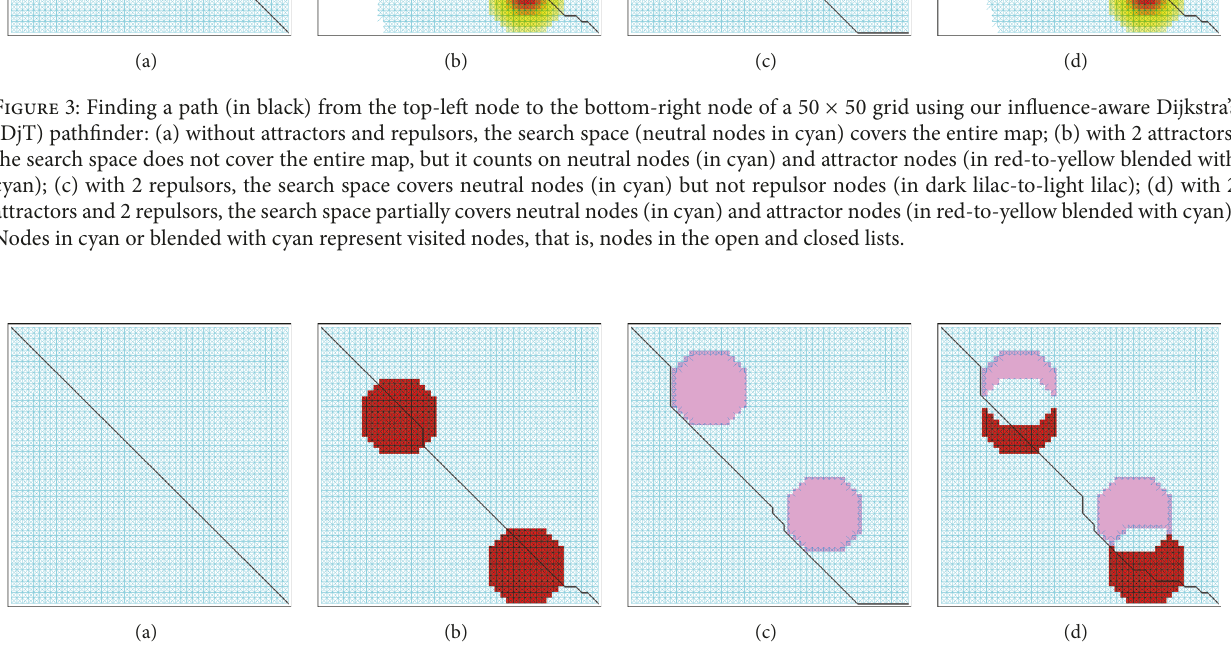
Figure 4: Finding a path (in black) from the top-left node to the bottom-right node of a 50 × 50 grid using the risk-adverse Dijkstra’s (DjRAP) pathfinder:(a)withoutattractorsandrepulsors,thesearchspace(neutralnodesincyan)coverstheentiremap;(b)with2attractors,thesearch space covers the entire map, including neutral nodes (in cyan) and influence-constant attractor nodes (in red blended with cyan); (c) with 2 repulsors, the search space covers neutral nodes (in cyan) but not influence-constant repulsor nodes (in light lilac); (d) with 2 attractors and 2 repulsors, the search space covers neutral nodes (in cyan) and influence-constant attractor nodes (in red blended with cyan) but not repulsor nodes (in light lilac). Nodes in cyan or blended with cyan represent visited nodes, that is, nodes in the open and closed lists.